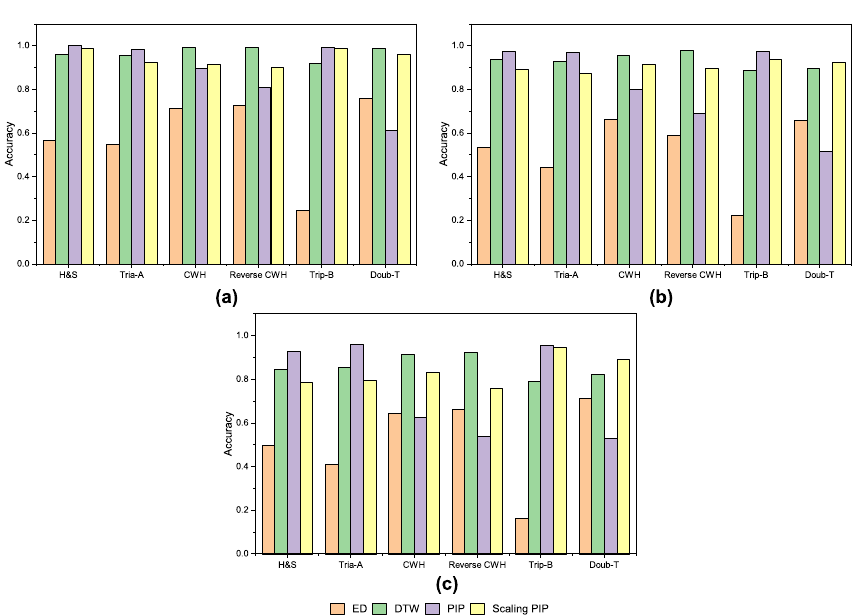
Figure 11. ( a ) The accuracy of each model with σ = 0.15. ( b ) The accuracy of each model with σ = 0.2. ( c ) The accuracy of each model with σ = 0.25.